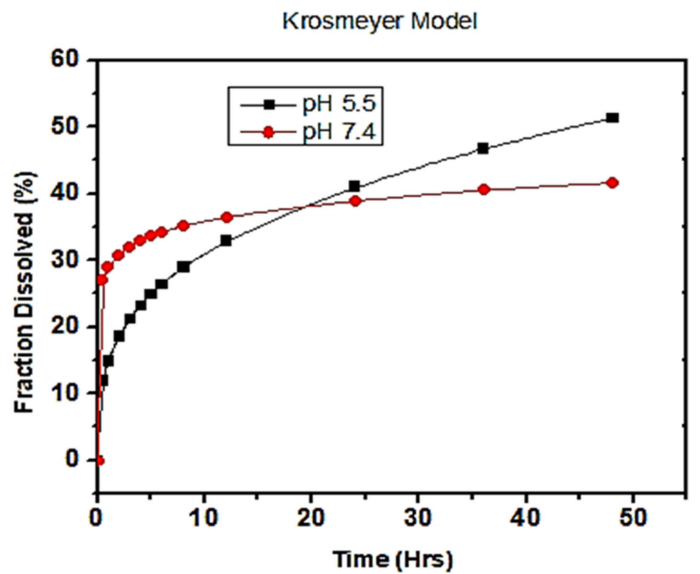
Figure 9. Korsmayer–Peppas kinetic models of drug release from polymeric nanoparticles at pH = 7.4 and pH =